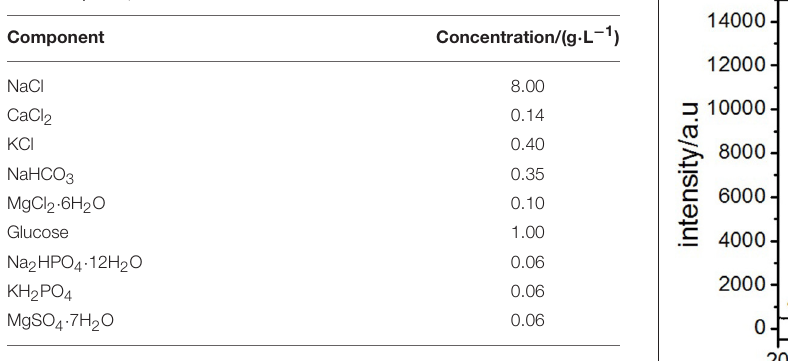
selected area electron diffraction (SAED) pattern along the (cid:2) 112 (cid:3) direction. According to the SAED pattern, the phase has face- centered cubic (fcc) structure with a lattice constant of 0.729